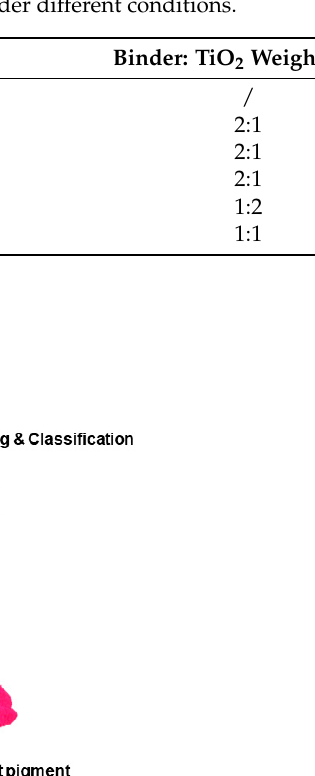
Table 1. Preparation of modified fluorescent pigments under different conditions.